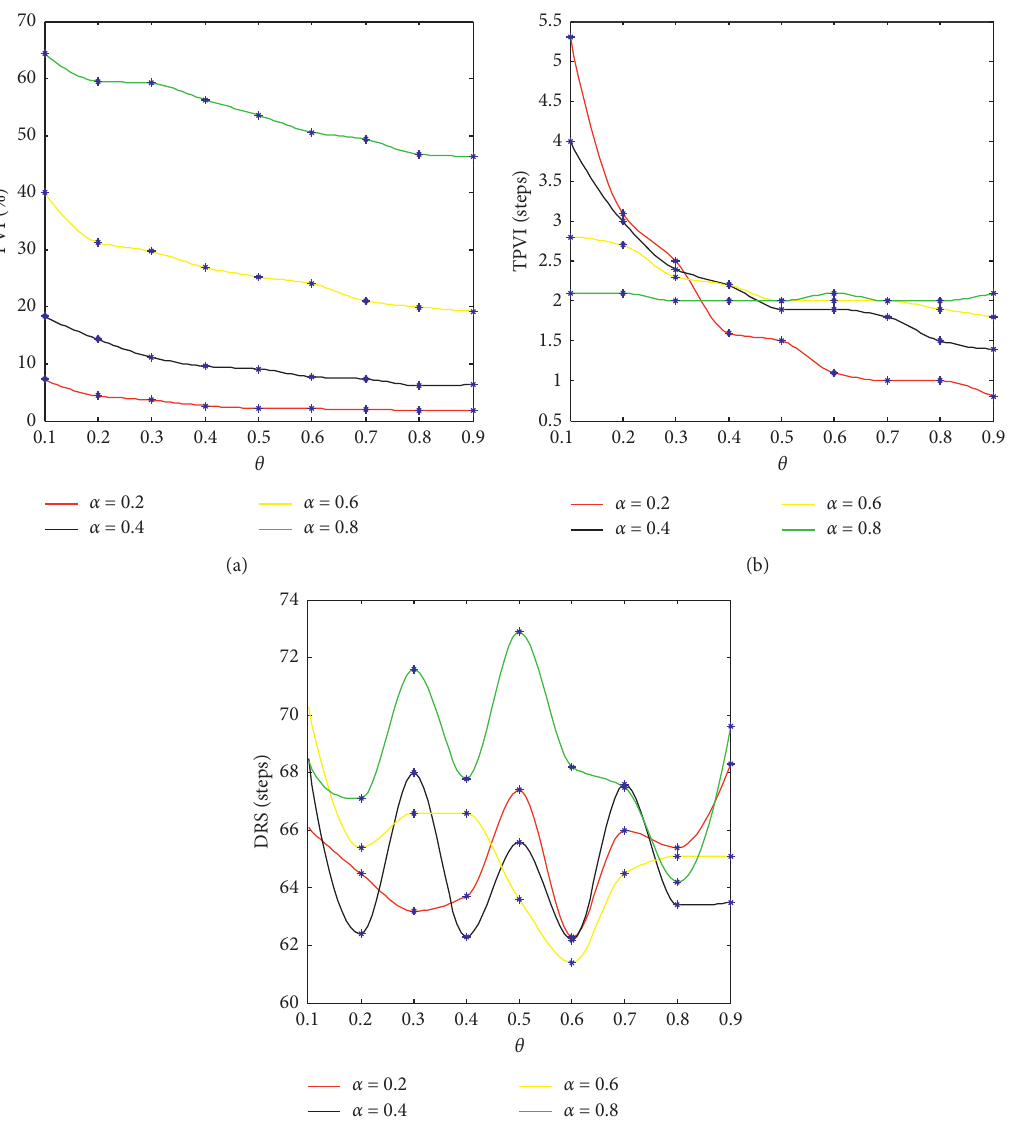
Figure 3: Influence of changes of rumor spreading rate α and self-purification level θ on three indicators PVI, TPVI, and DRS. Simulations are conducted under the condition a TPVI change, and (c) DRS